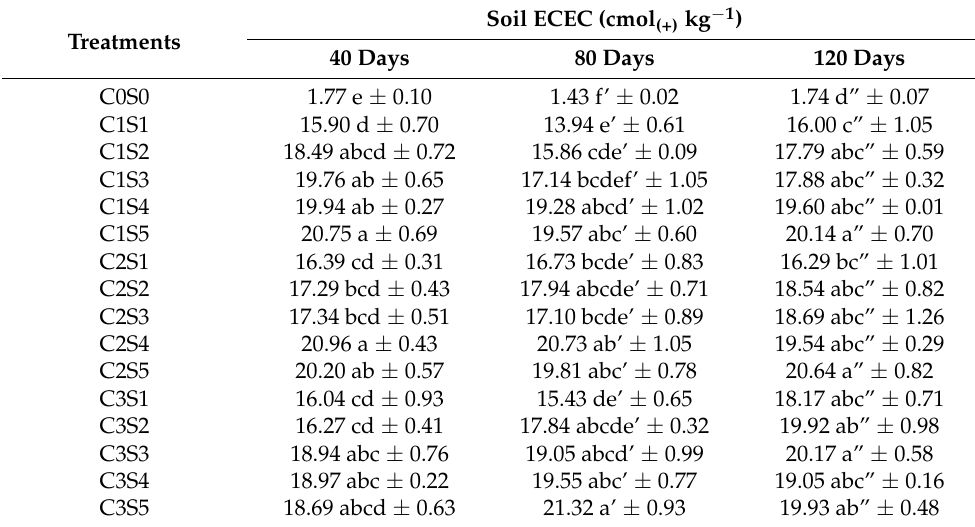
Means (value ± standard error) with different letters within the same column indicate significant differences using Tukey’s test with p ≤ 0.05. Small letters, small letters with ’, and small letters with ” indicate mean comparison at forty, eighty, and one hundred and twenty days incubation,